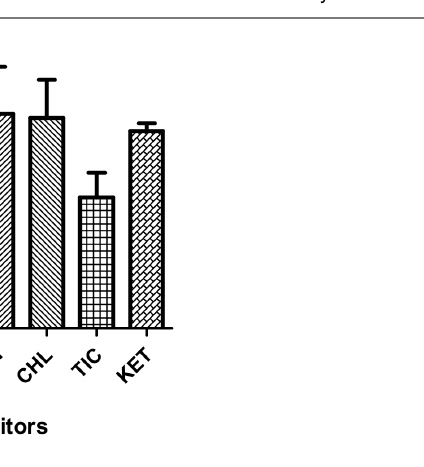
Figure 2. Effect of specific inhibitors on CYP-mediated MH (10 m M) metabolism in HLMs. Note: The concentrations of CHL was 5 m M and that for the other specific inhibitors was 1 m M. The incubation conditions are described in the materials and methods section. Each data point represents the average of triple determinations and error bars (n 5 3). FUR, furafylline, the specific inhibitor for CYP1A2; TRA, trans-2- phenylcyclopropylamine, the specific inhibitor for CYP2A6; SUL, sulfaphenazole, the specific inhibitor for CYP2C9; QUI, quinidine, the specific inhibitor for CYP2D6; CLM, chlormethiazole, the specific inhibitor for CYP2E1; TIC, ticlopidine, the specific inhibitor for CYP2C19; and KET, ketoconazole, the specific inhibitor for CYP3A4. In the presence of FUR (1 m M) and TIC (1 m M), the metabolic clearance rate of MH decreased to 29.1% and 41.3% of that of the control, respectively, while the other inhibitors had no significant inhibitory effects on the metabolism of MH.